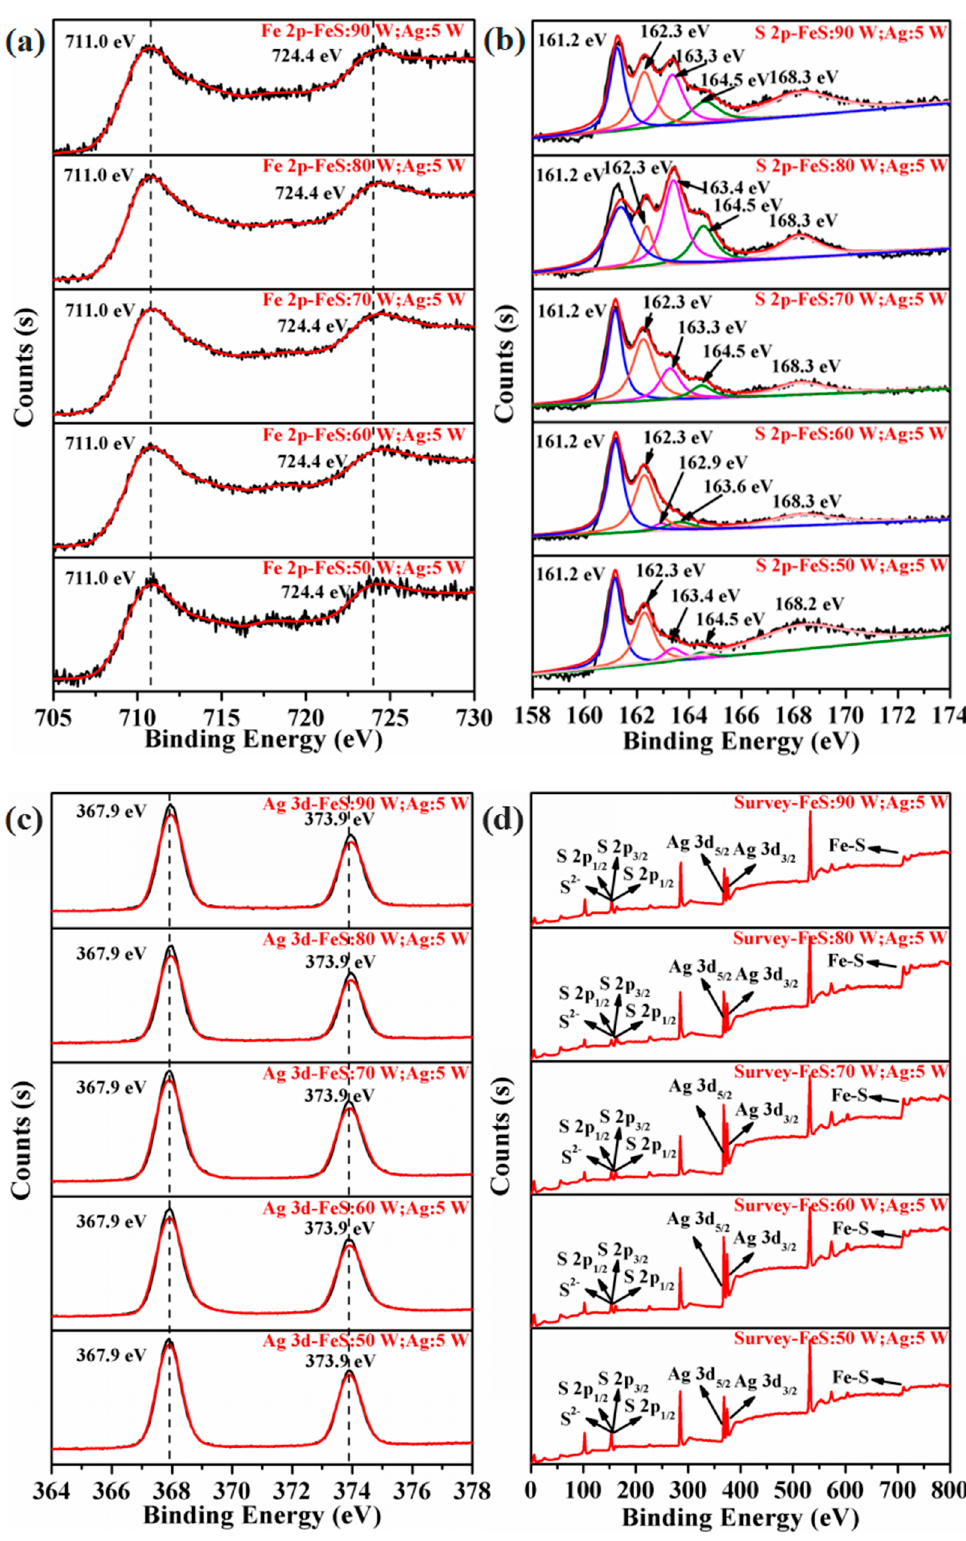
Figure 3. The XPS spectra of cosputtered Ag (5 W sputtering power) and FeS (50 W, 60 W, 70 W, 80 and 90 W sputtering power) deposited for 300 s on the PSCP templates: Fe 2p ( a ), S 2p ( b ), Ag 3d ( c ) and survey ( d ) spectra.